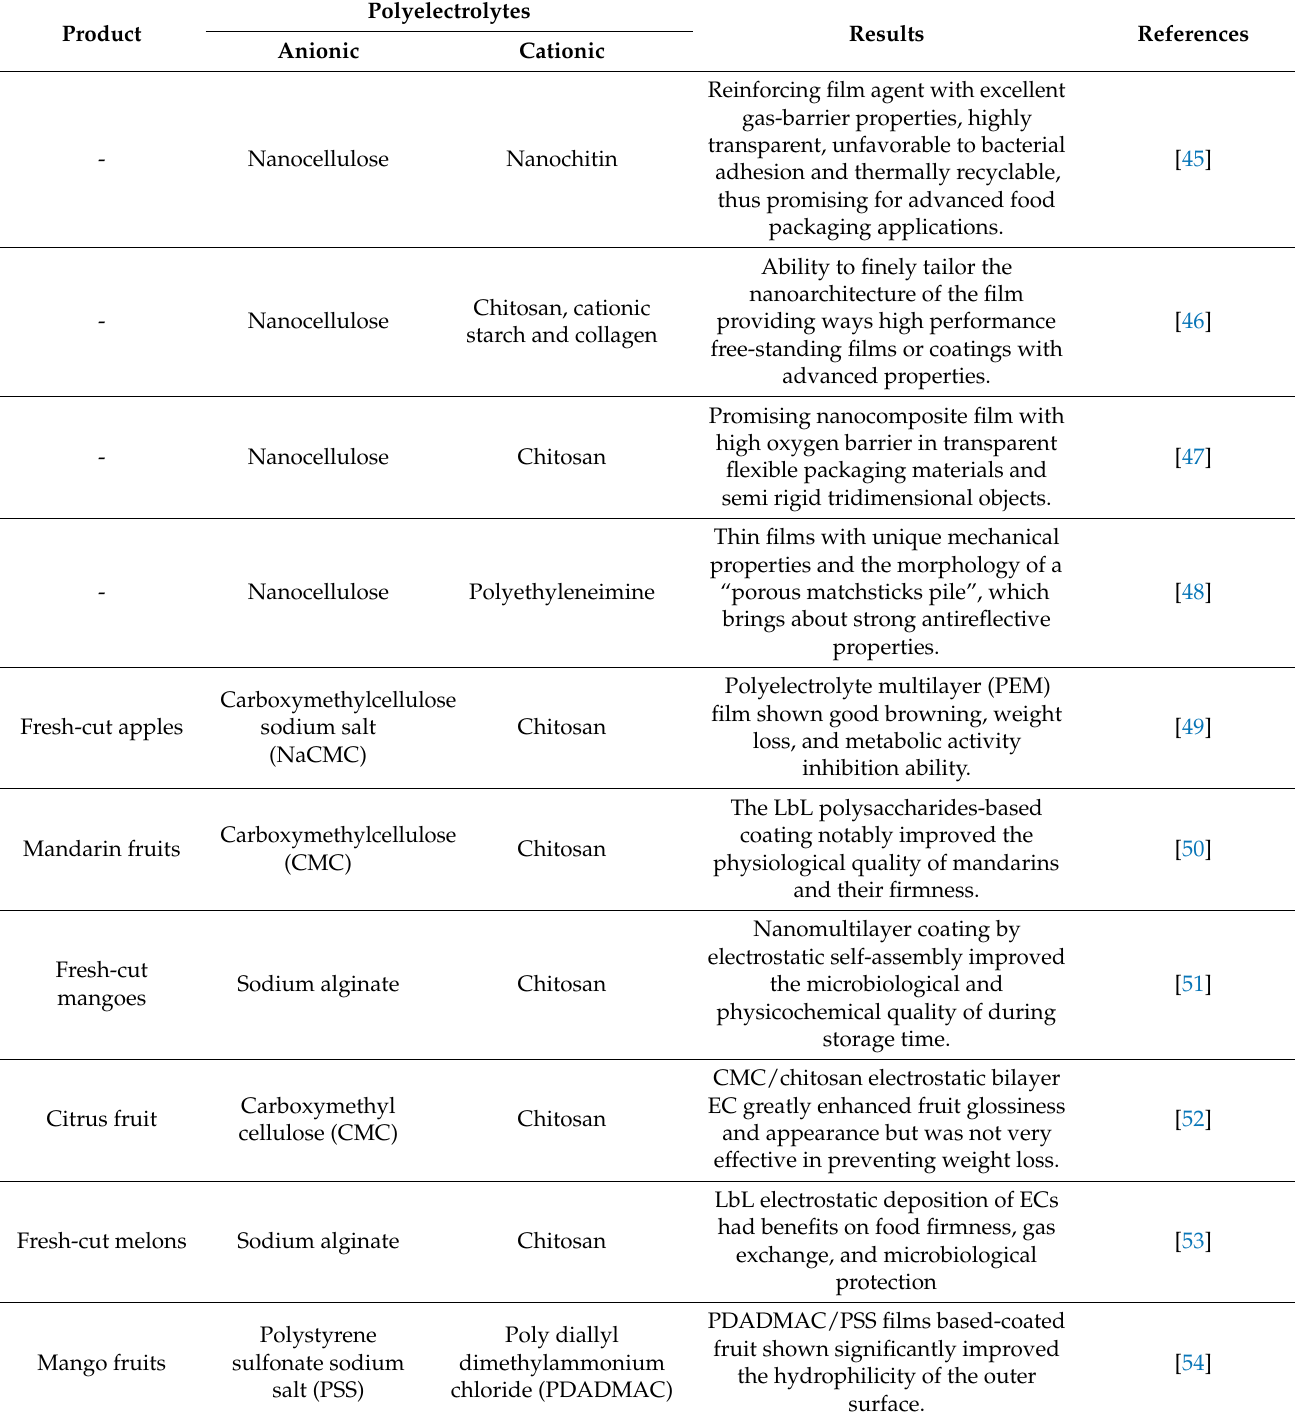
Table 1. Applications of electrostatic layer-by-layer (LbL) coating deposition methods for different food